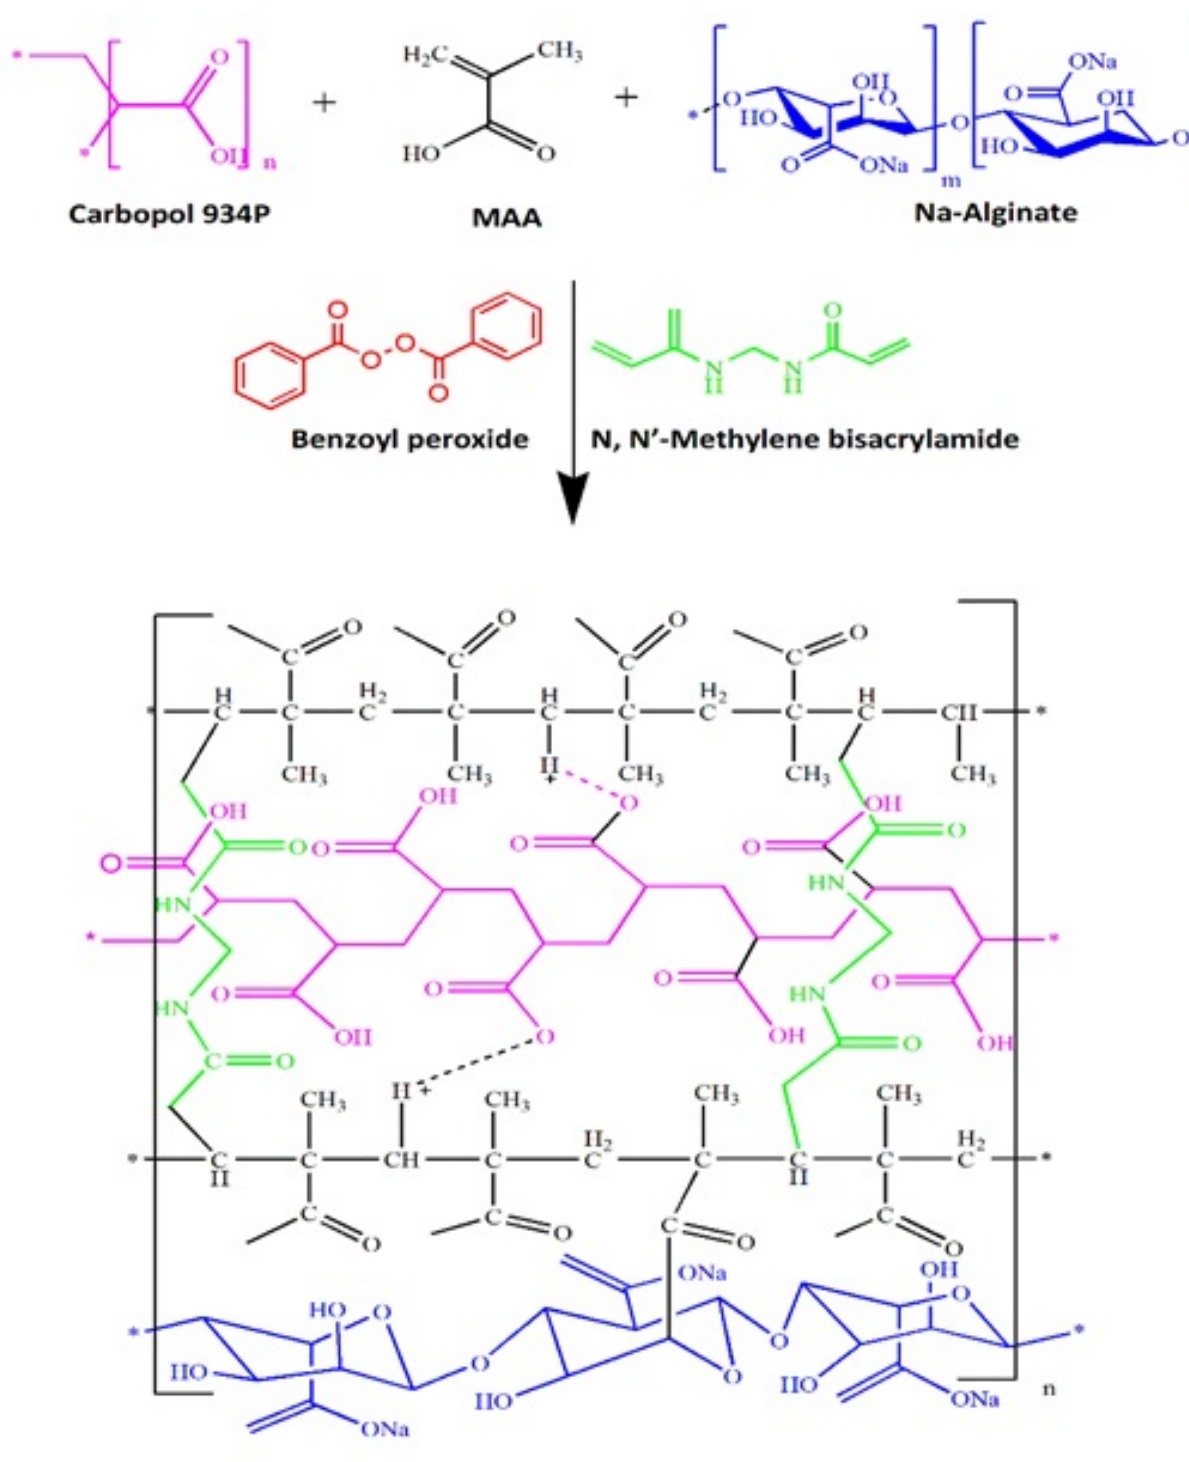
Figure 1. Proposed chemical structure of Na-Alg/CP-co-poly(methacrylate) hydrogel .